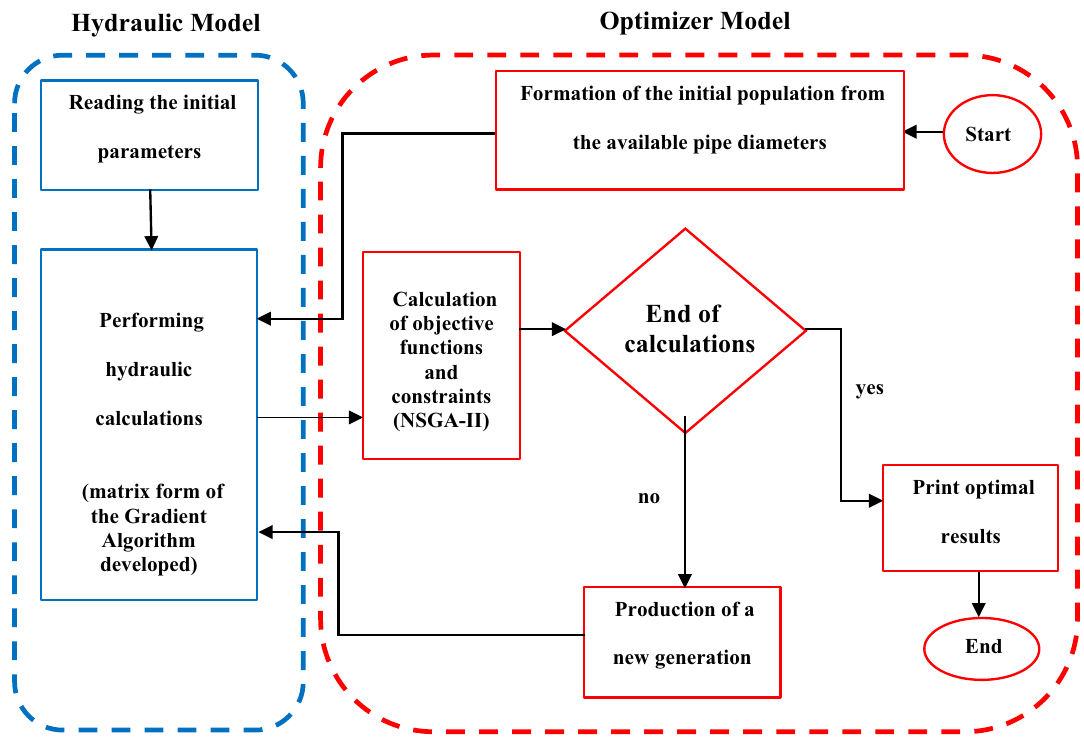
Fig. 2 General process of WDNs cost–benefit optimizer